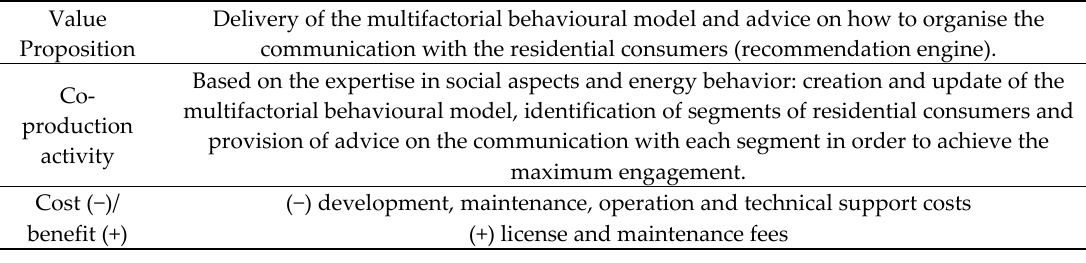
Table 5. Sensing Components Retailer.